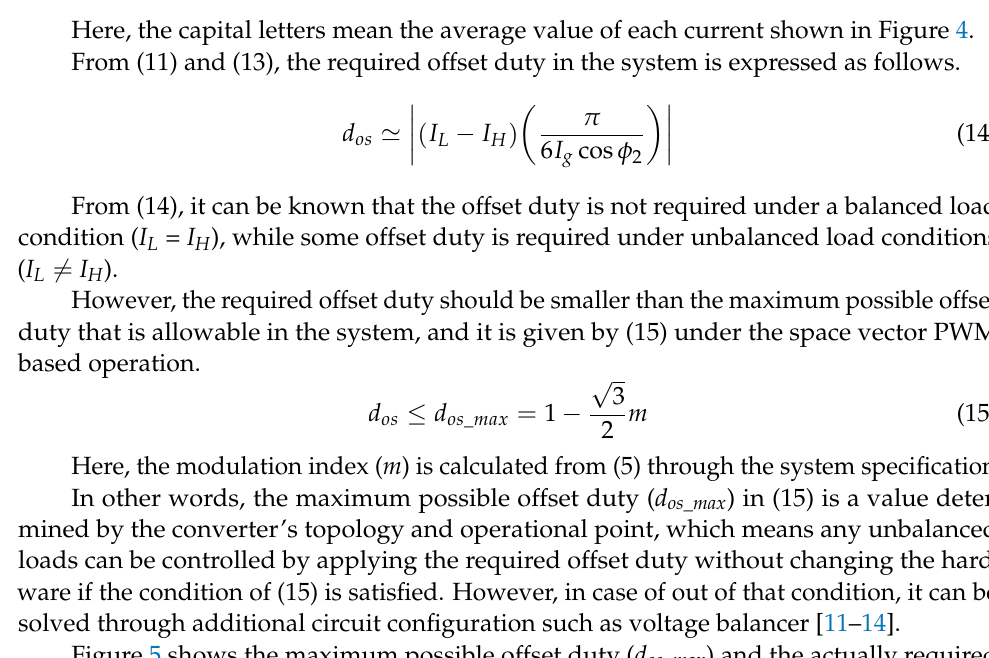
Table 1. System Specifications.